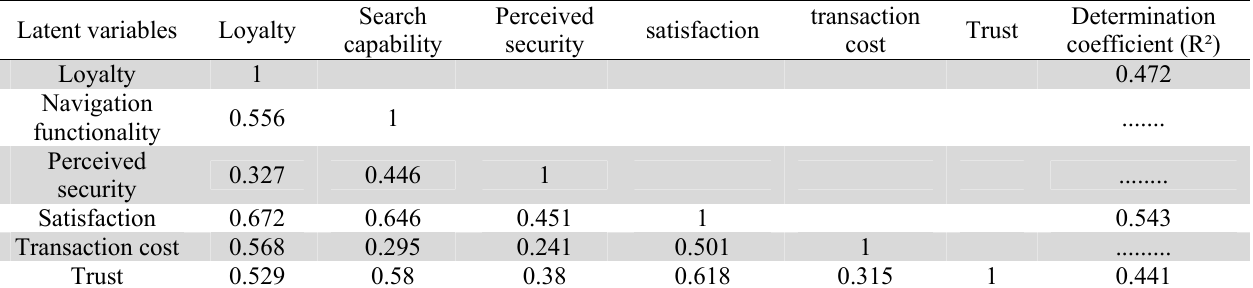
Pearson correlation coefficients related to hidden variables and coefficients of dependent variables